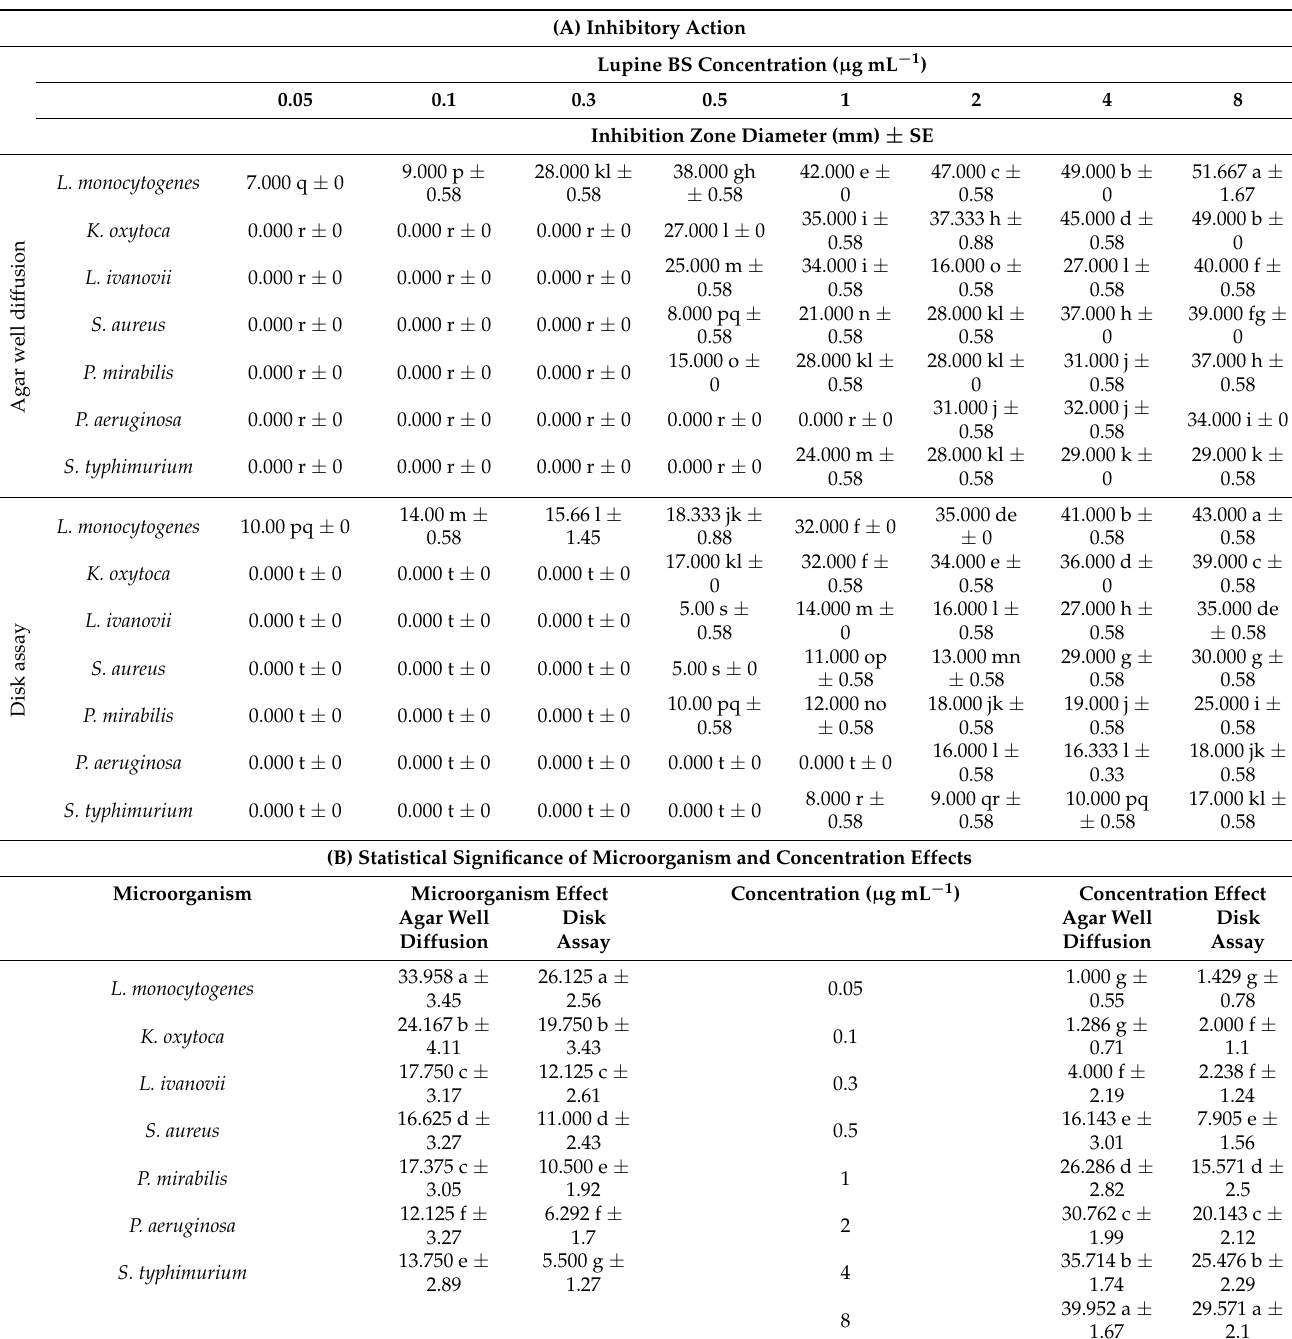
Table 2. Bacterial inhibitory actions of graded concentrations of lupine BS using agar well diffusion and disk assay techniques ( A ) and statistical significance ( B